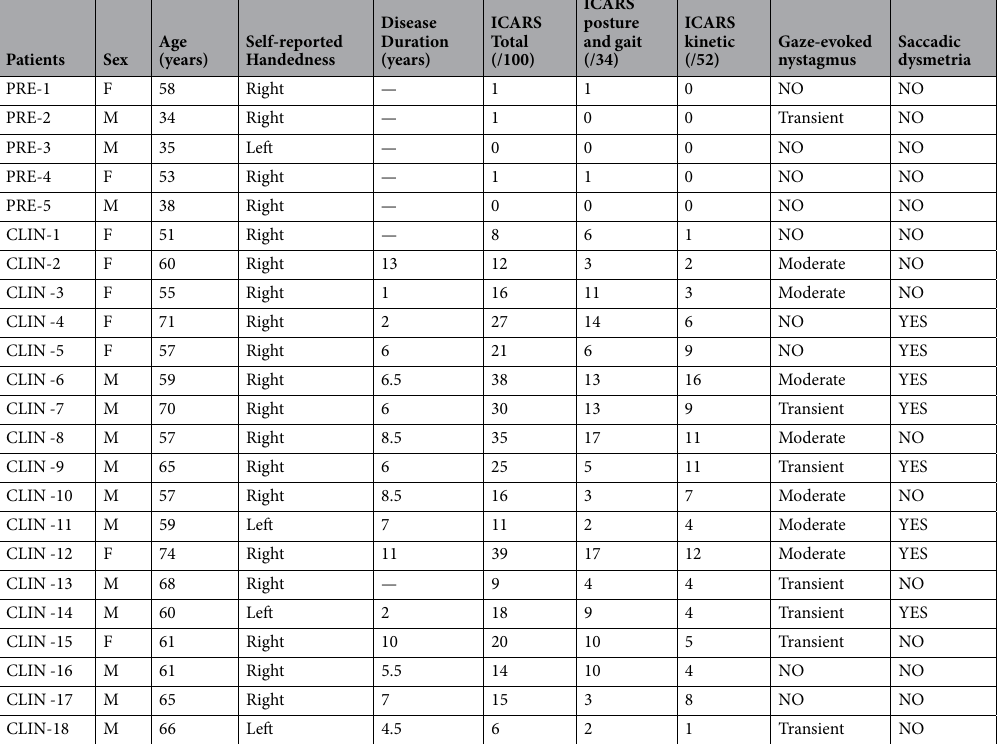
Table 1. Demographic and clinical characteristics of the SCA6 individuals. PRE: pre-clinical individuals; CLIN: clinical patients; ICARS: International Cerebellar Ataxia Rate Scale. Gaze-evoked nystagmus (GEN) and saccadic dysmetria were assessed with the ICARS. The scale assesses whether the GEN was present, transient, moderate or severe. It also allows reporting the presence or absence of saccadic dysmetria. Disease duration was self-reported as the time where the first symptoms were noticed by the